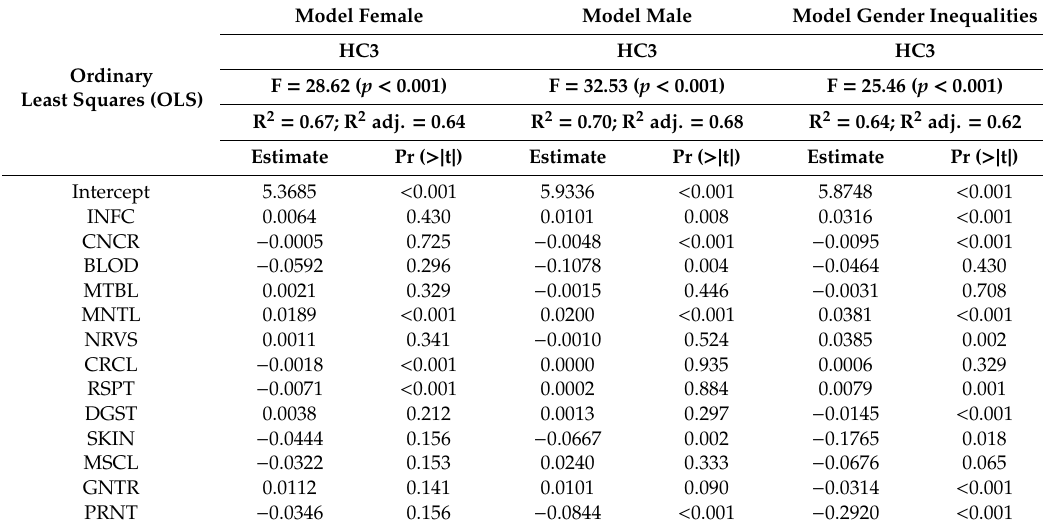
Table 2. Regression models